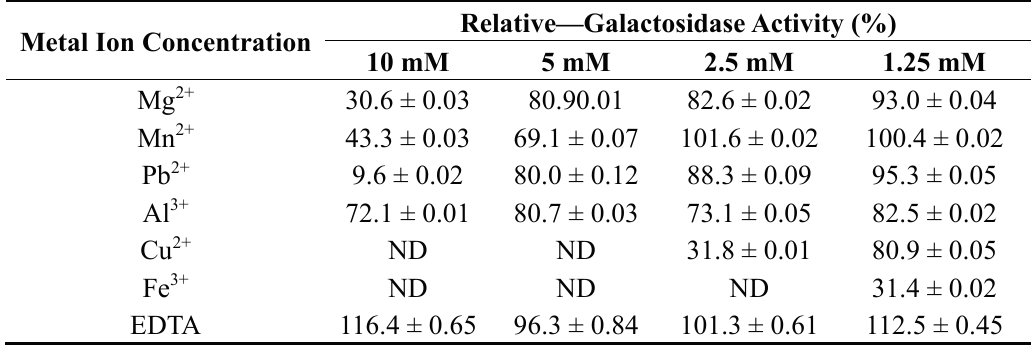
Table 2. Effects of different metal ions on activity of Tricholoma matsutake α -galactosidase a